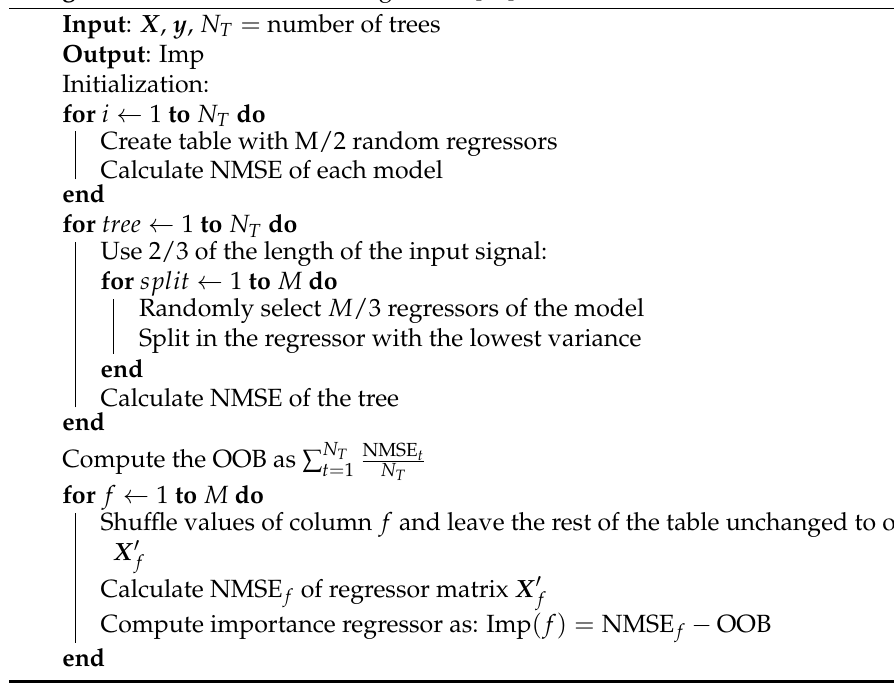
Algorithm 4: Random Forest algorithm [17].